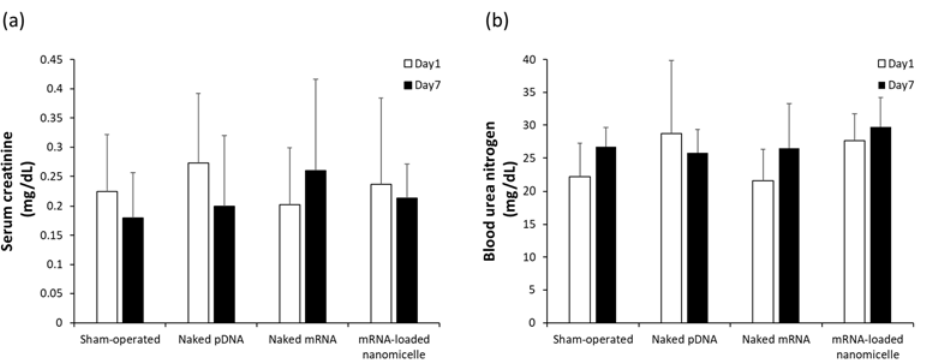
Figure 4. ( a ) Serum creatinine (Cre) and ( b ) Blood Urea Nitrogen (BUN) levels after renal pelvis injection of messenger RNA (mRNA) or plasmid DNA (pDNA). The blood was collected on day 1